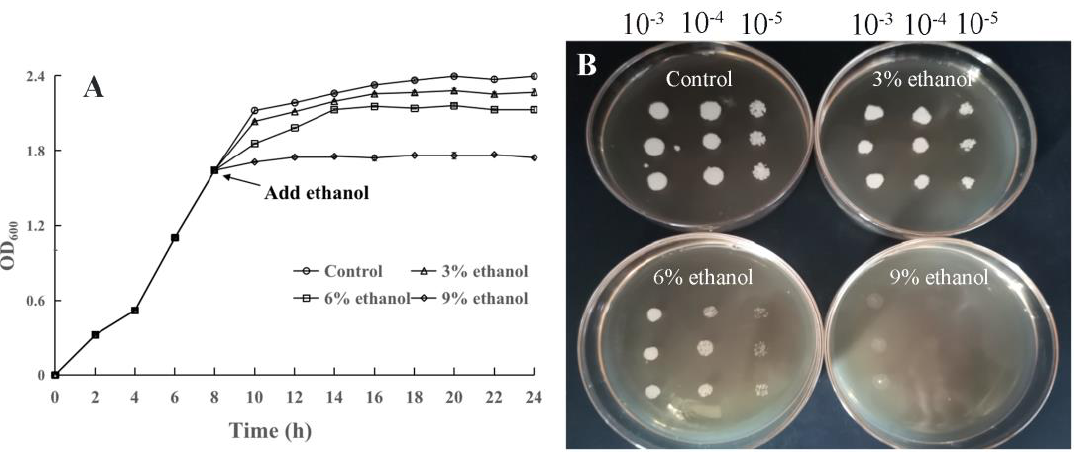
Figure 1. Effects of ethanol stress on the growth of P. anomala NCU003 in liquid medium ( A ) and solid medium ( B ).